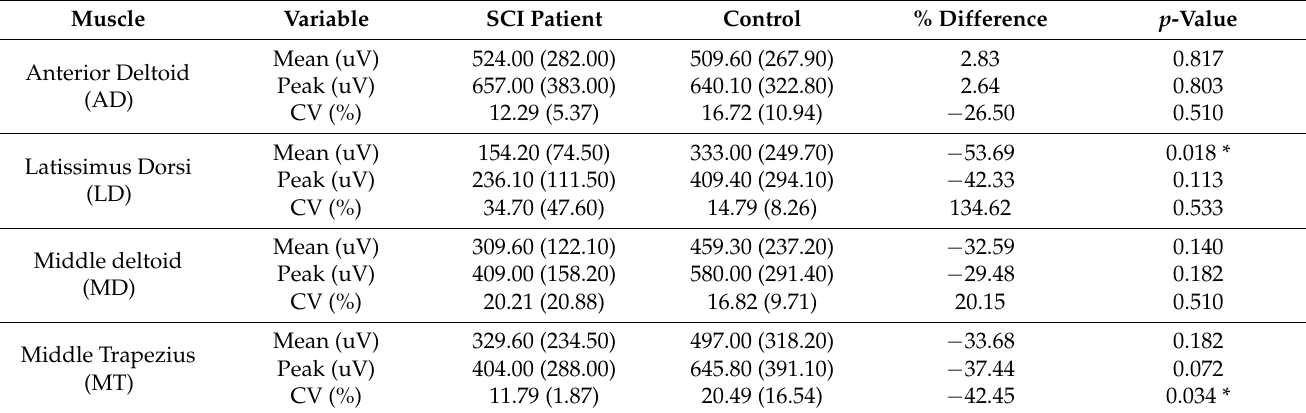
Table 2. Descriptive statistics and p -values of individual muscles associated with the shoulder joint between the SCI group and the control